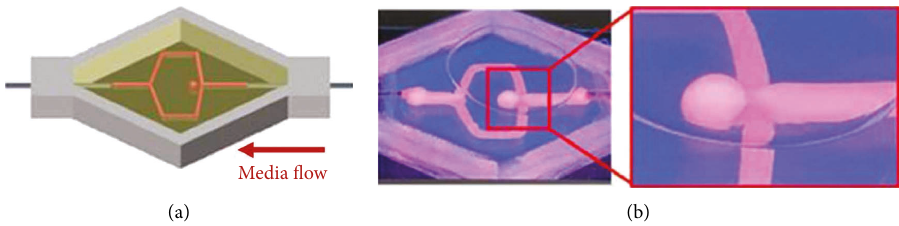
Figure 3: Flowchart showing 3D printing applications in neurosurgery and the in vitro living cerebral aneurysm. (a) Illustration of the 3D- printed aneurysm bioreactor. (b) The in vitro aneurysm vessel structure perfused with red fluorescent beads, demonstrating the formation of the patent vessel postevacuation of sacrificial ink; reprinted with permission under open access by Jang et al. [70].